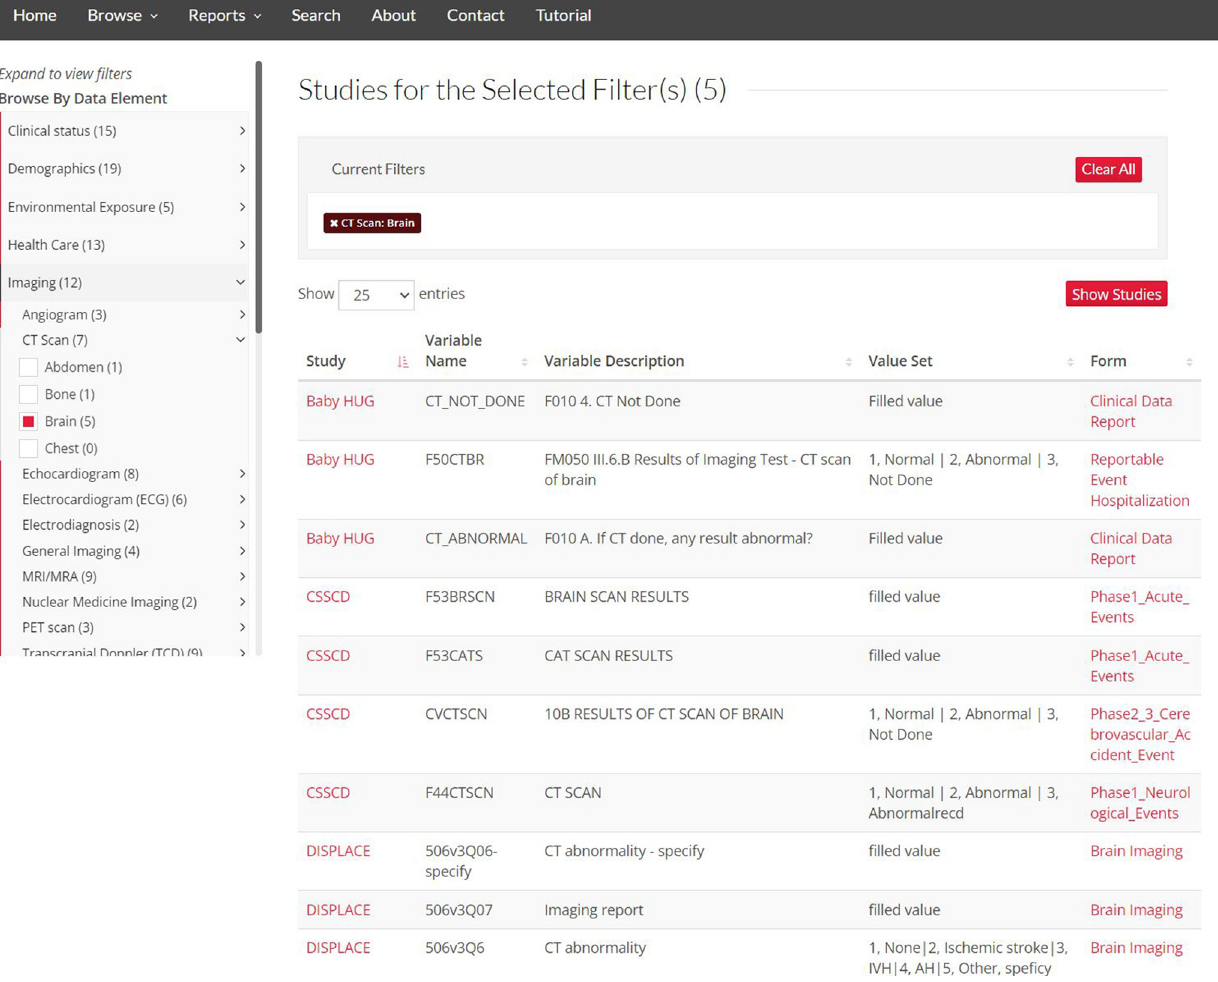
Fig 3. The “Browse Studies by Data Element” tool. The “Show Variable” feature lists study variables information. Republished from https://curesicklecell.rti. org/ under a CC BY license, with permission from Public Library of Science (PLOS), original copyright 2022.